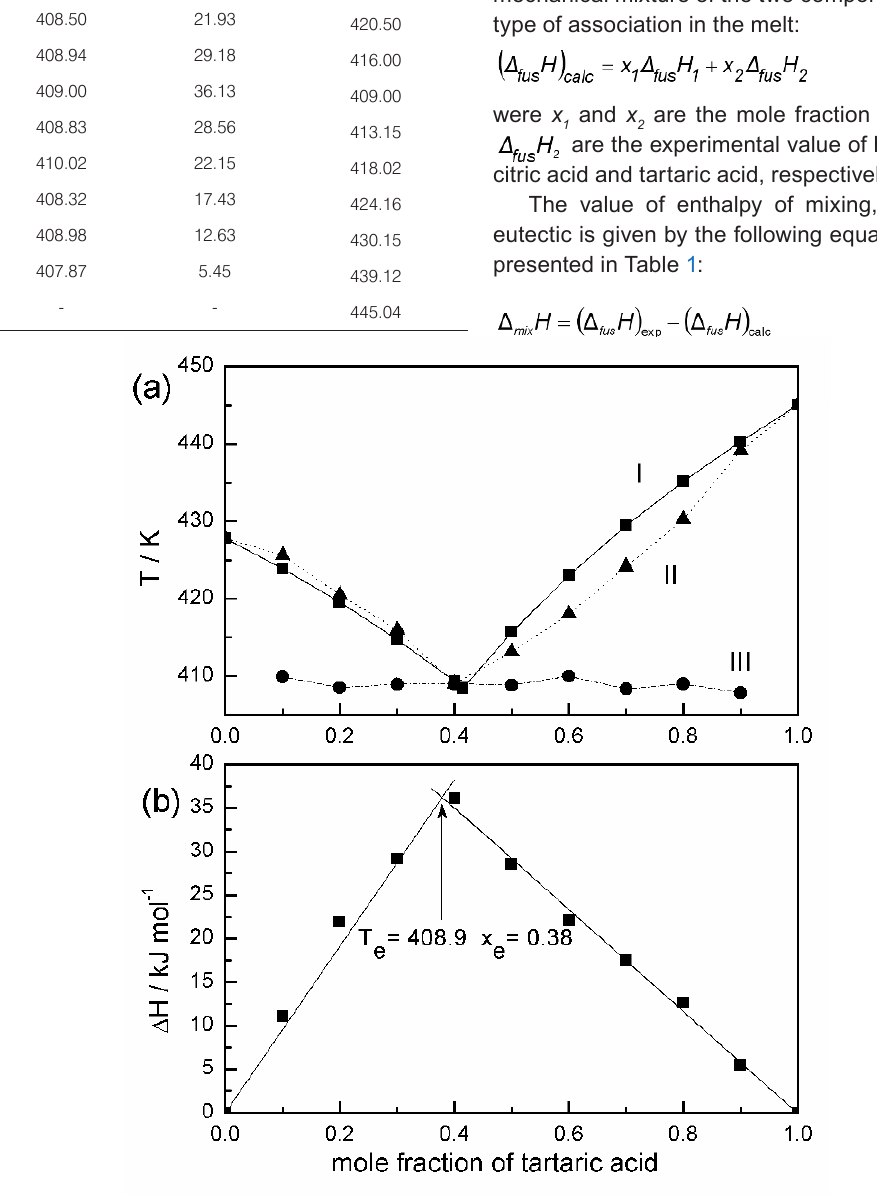
Figure 2. a) solid – liquid phase diagram for binary mixture citric acid - tartaric acid. (I) Ideal curve; (II) liquidus curve; (III) solidus temperature curve. b) Tamman plot of binary system citric acid - tartaric